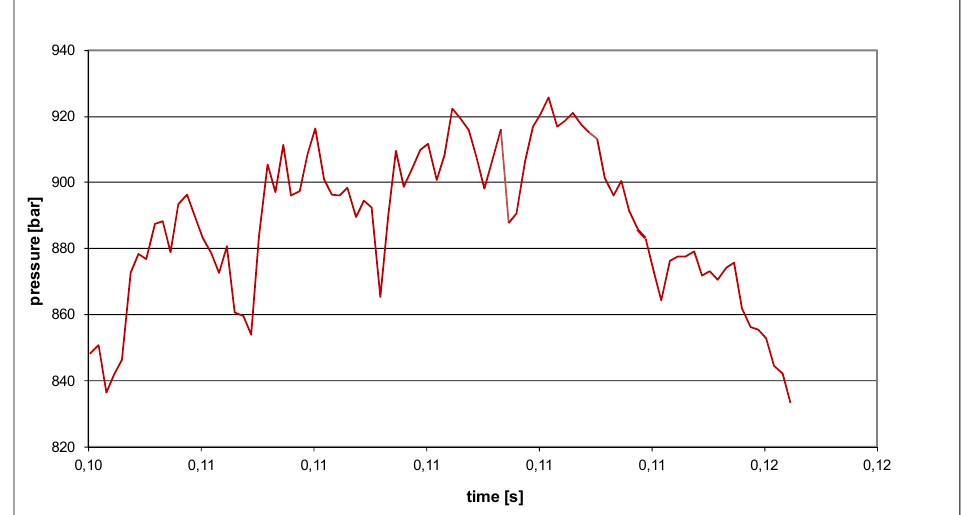
Figure 7. Increase in fluid pressure under load in progress. Figure 8. Increase in fluid pressure under load in